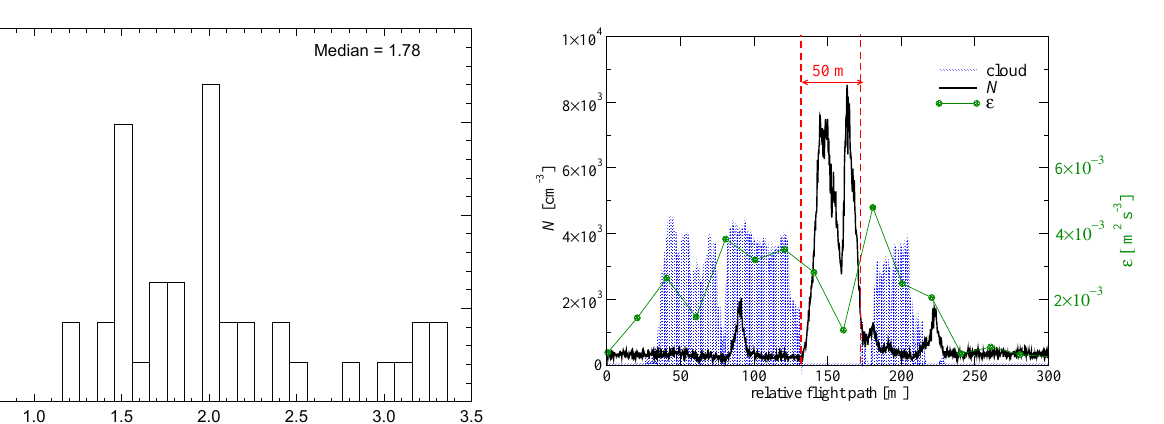
Figure 10. Penetration of a cloud field with a burst of increased number concentrations N of ultrafine particles between two cloud penetrations. The clouds are marked by the blue areas, which rep- resent LWC in arbitrary units. Additionally, the dots show the lo- cal energy dissipation rate ε averaged over a relative flight path of roughly